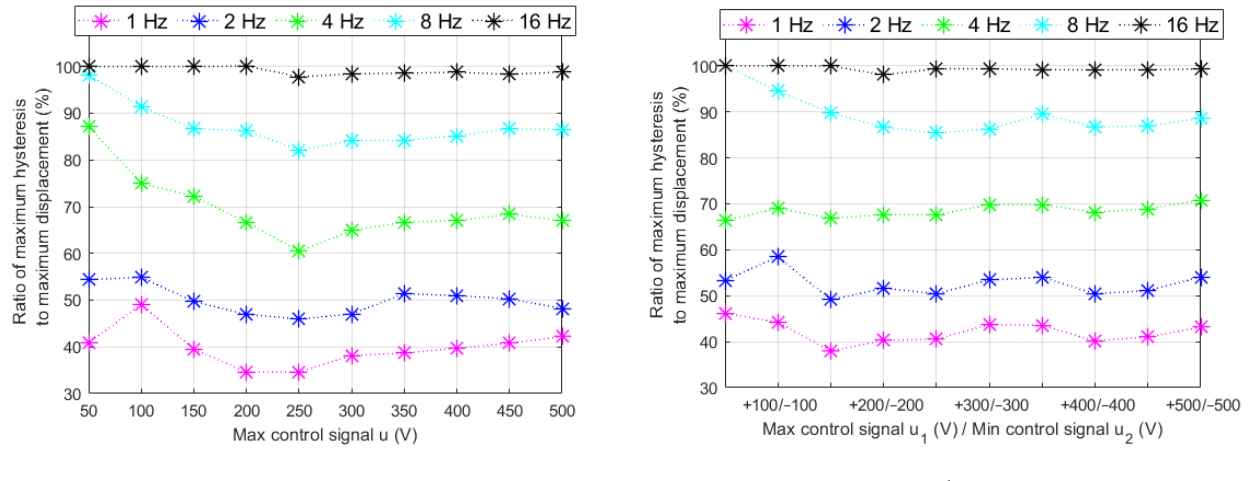
Figure 14. Ratio of maximum hysteresis to maximum displacement of the actuator beam tip: ( a ) in the motion of the unimorph, ( b ) in the motion of the bimorph.